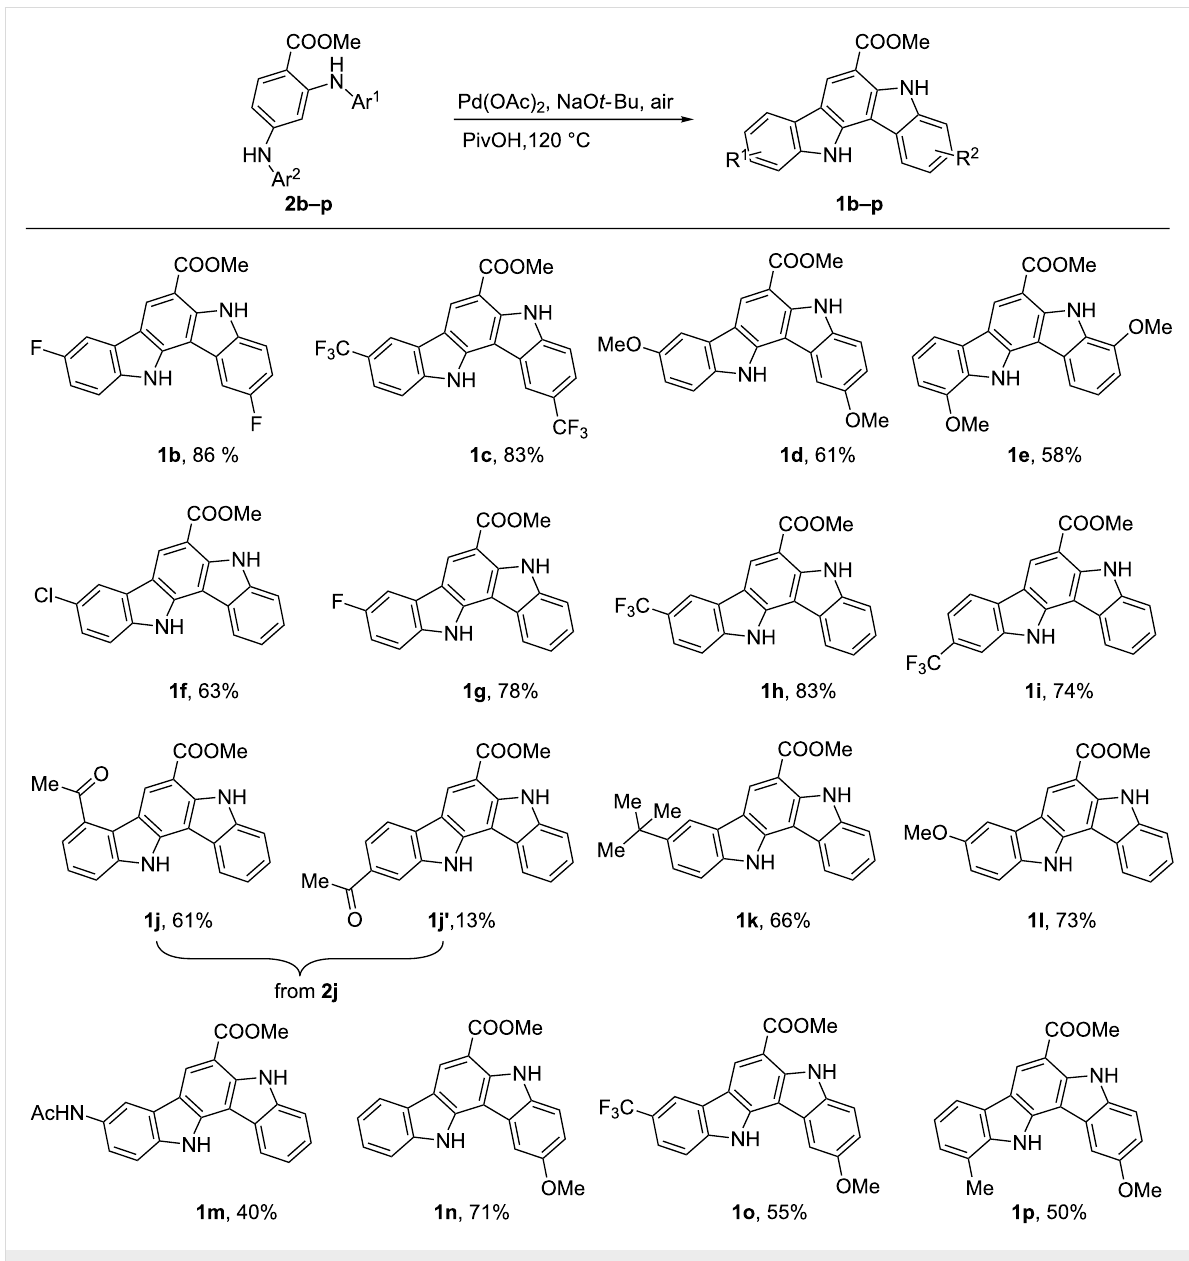
Scheme 3: Substrate scope for Pd-catalyzed twofold